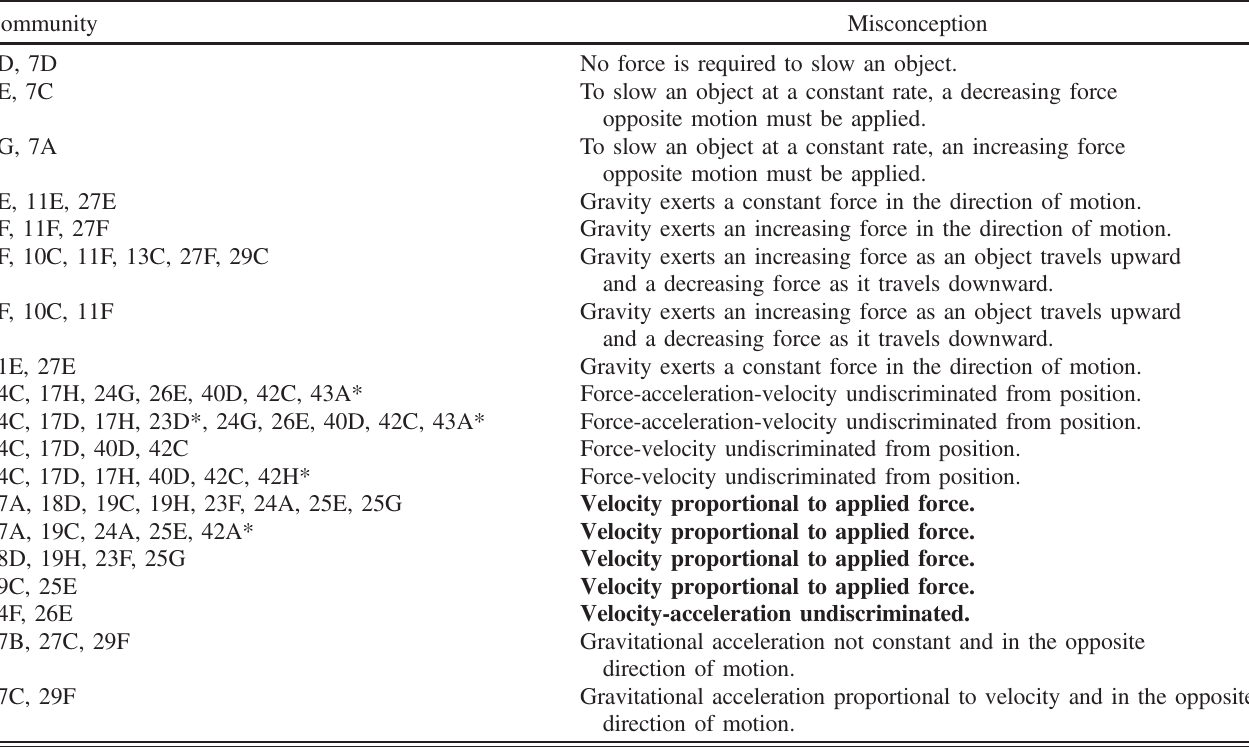
TABLE V. Misconceptions represented by communities identified in items selected by at least 10% of the students which were not identified in items selected by at least 20% of the students. Items marked * do not have an obvious relation to the misconception. Misconceptions identified by Hestenes and Jackson [24] are